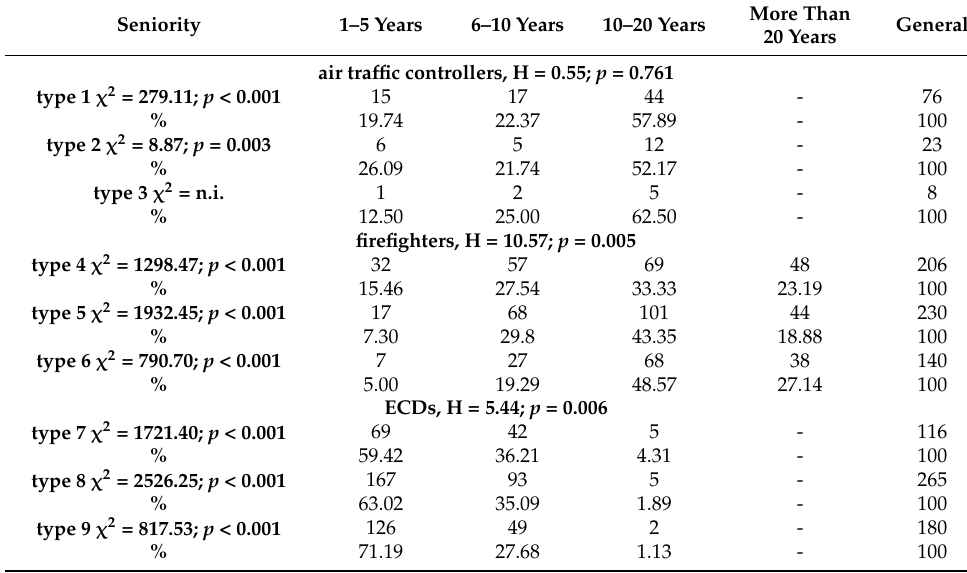
Table 6. Differences in terms of seniority according to the profile of occupational burnout in the groups of air traffic controllers, firefighters, and